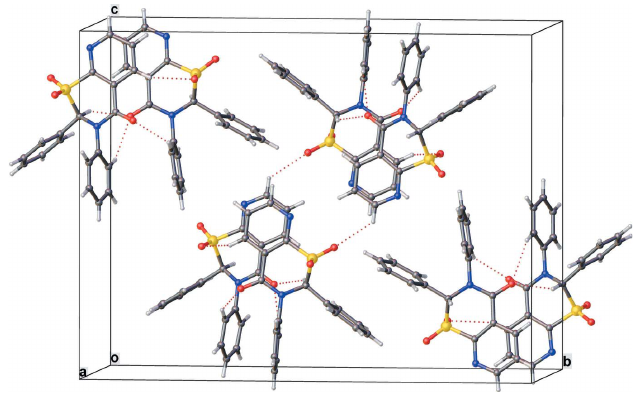
Figure 5 Crystal packing diagram for 2 showing strong similarity with that of 1 .